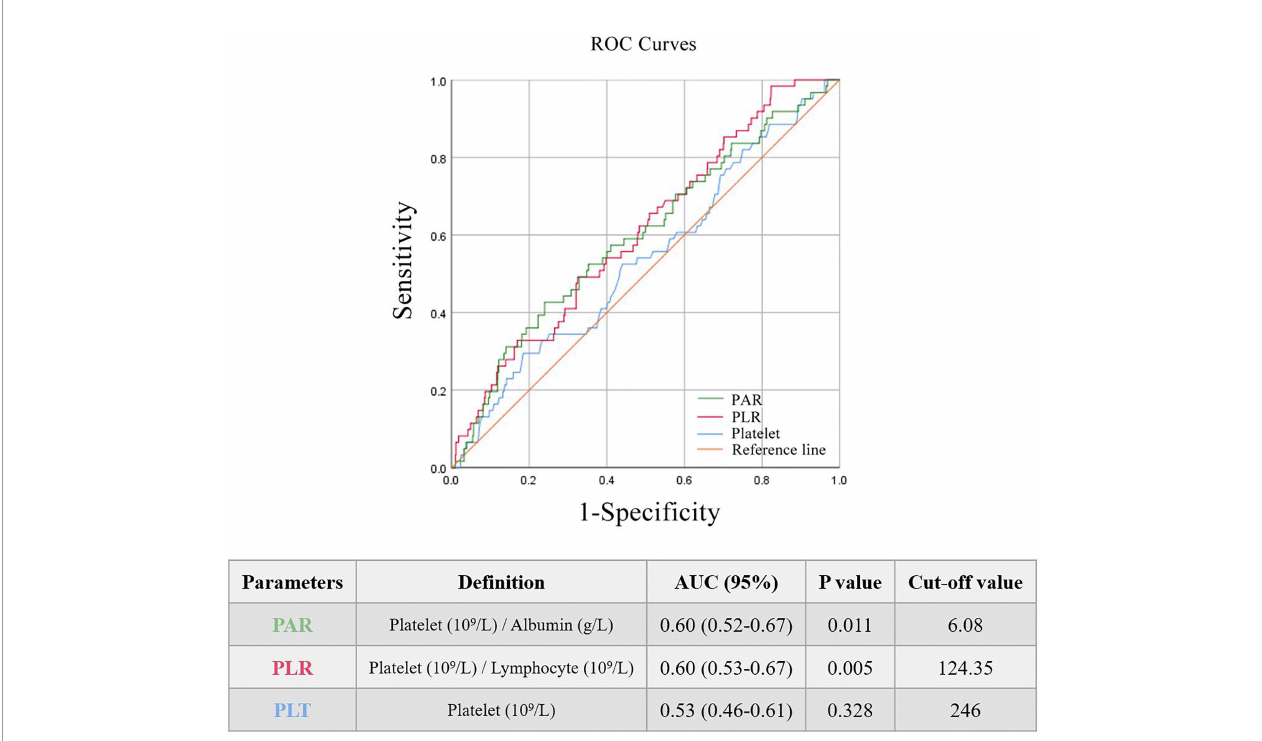
FIGURE 1 | The areas under the ROC curves of platelet-related